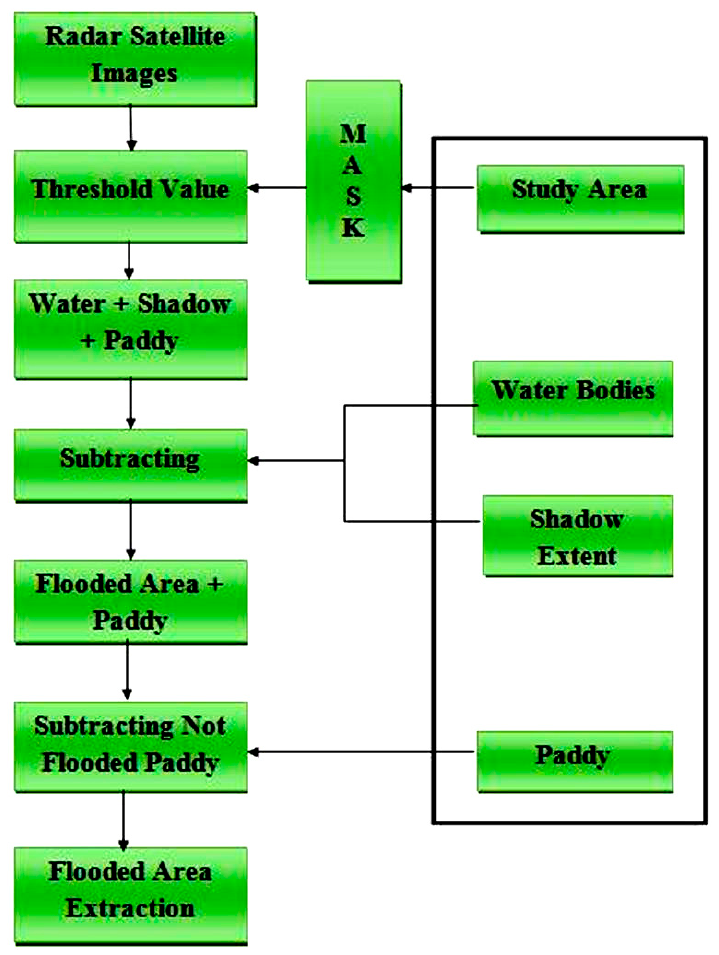
Figure 4. Flow chart for flooded area extraction from RADARSAT image [4].